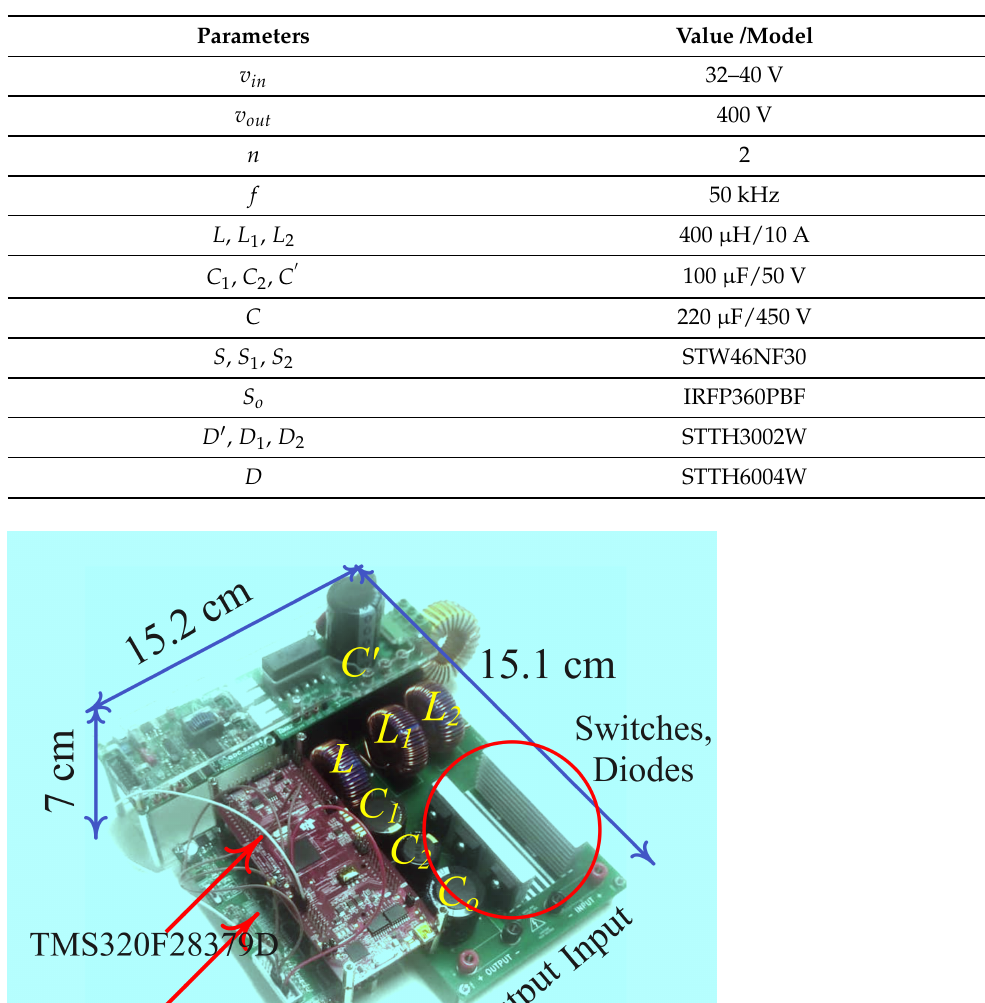
Table 2. Parameters of designed ML converter.